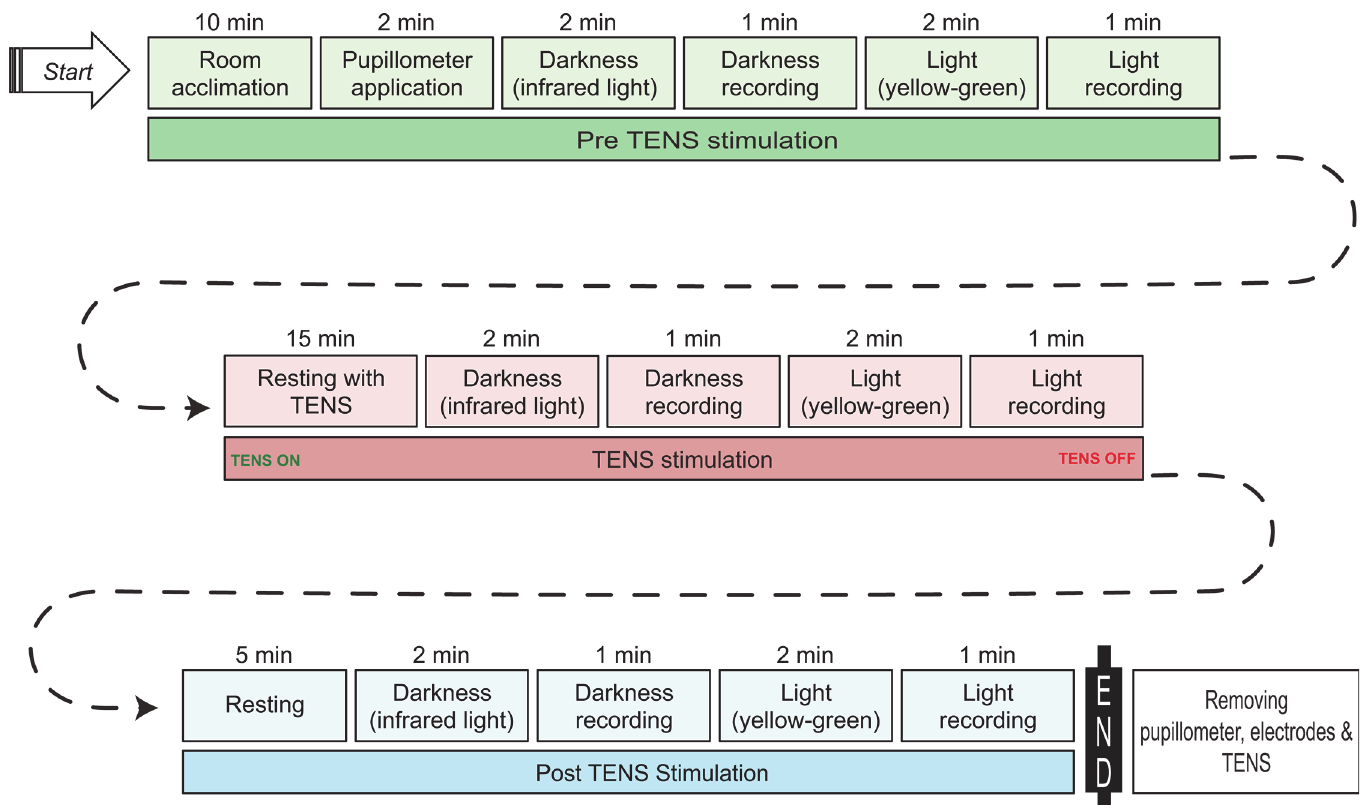
Fig 1. Diagram of the Experimental Protocol. Before beginning the experimental session, each enrolled subject was prepared with TENS electrodes and connected to a turned-off TENS device. Subsequently, they underwent three experimental phases: Pre TENS stimulation (green); During TENS stimulation (red); and Post TENS stimulation (blue). Pupillometer application and its removal occurred after the acclimation period and at the end of the experimental session, respectively (green). Based on the literature, central nervous system stimulation was obtained by sensory stimulation of cranial nerves V and VII with low-frequency TENS for 21 minutes (red) [28 – 32]. To avoid operator interference, the pupillometer, electrodes and TENS device were removed only at the end of the experimental